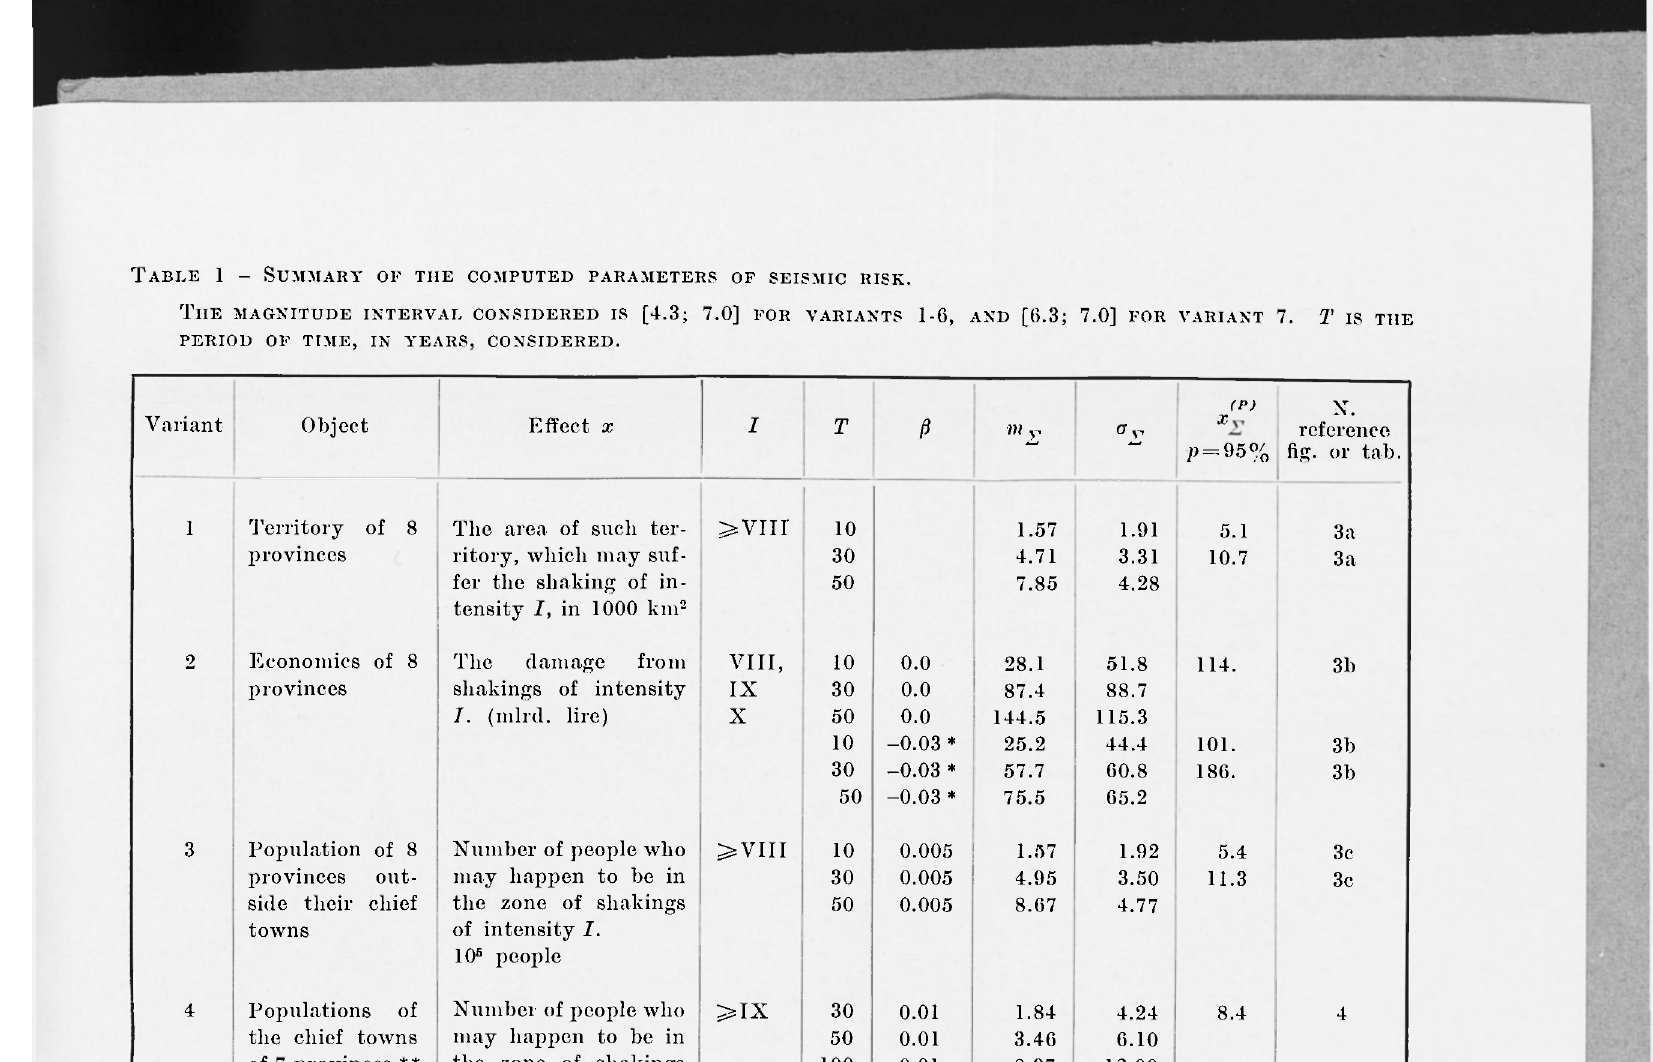
TABLE 1 - SUMMARY OF THE COMPUTED PARAMETERS OF SEISMIC RISK. T HE MAGNITUDE INTERVAL CONSIDERED IS [4.3; 7.0] FOR VARIANTS 1-6, AND [6.3; 7.0] FOR VARIANT 7. T is THE PERIOD OF TIME, IN YEARS,